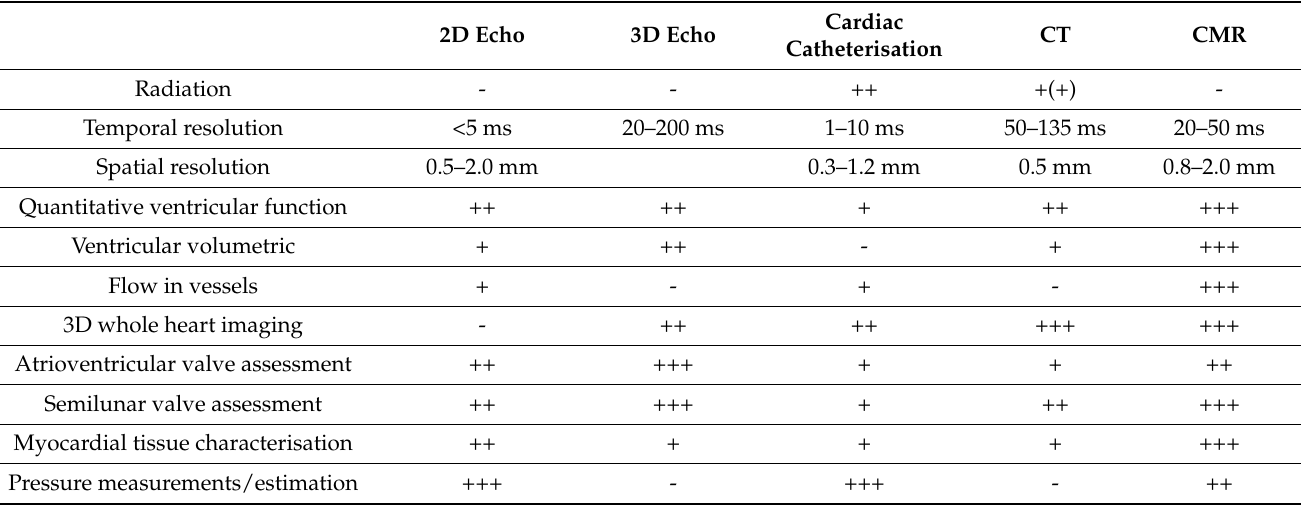
Table 1. Characteristics of different imaging modalities [5] (licensed under the Creative Commons Attribution 4.0 International